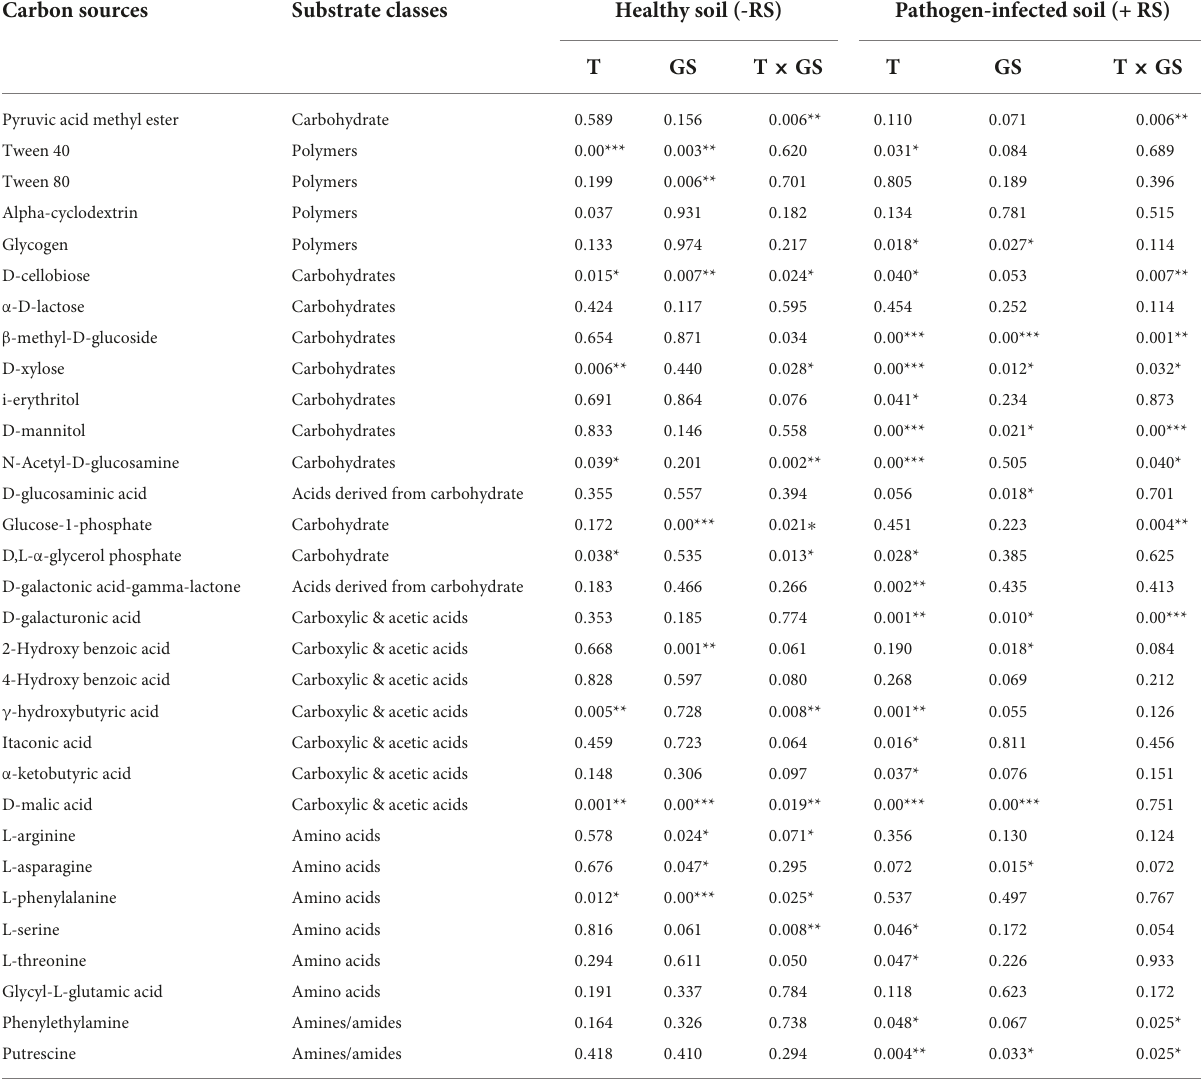
TABLE 2 The P -values of PERMANOVA of carbon substrates under healthy and R. solani infected soil during the plant development. Carbon